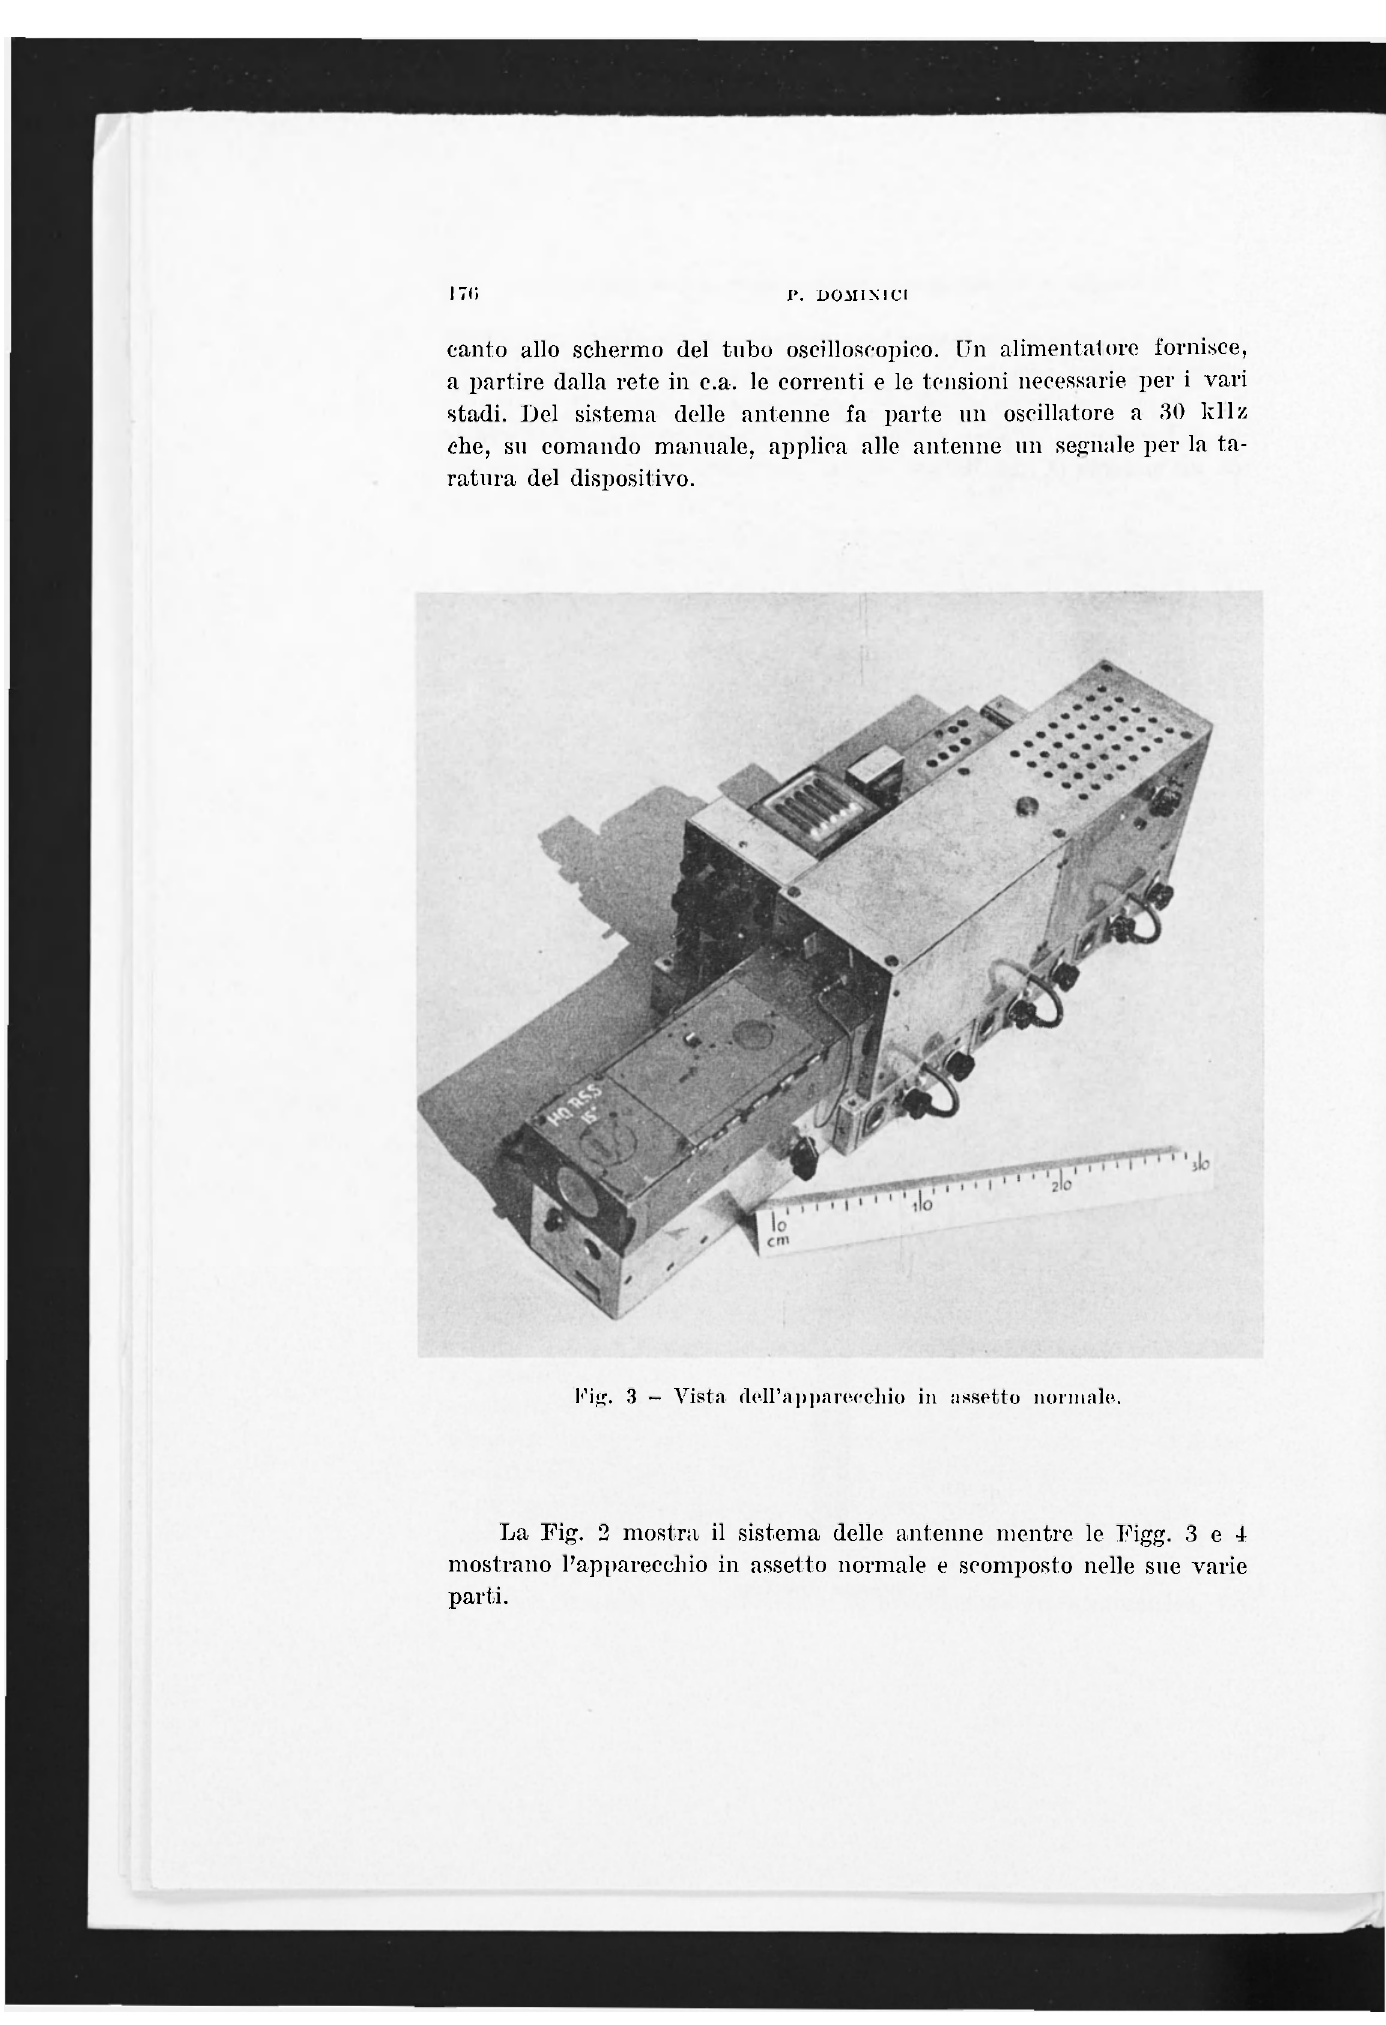
La Fig. 2 mostra il sistema delle antenne mentre le Figg. 3 e